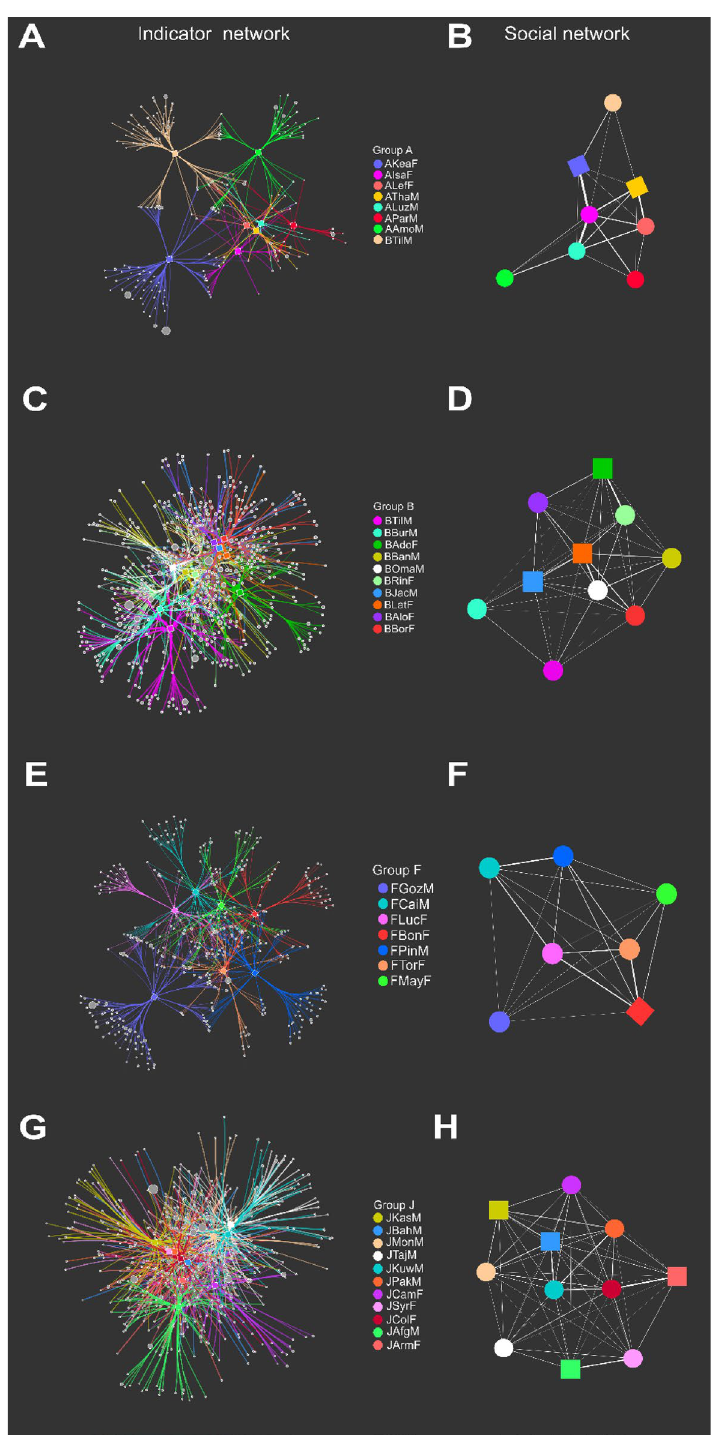
Figure 5. Indicative networks and social networks for the individuals of each group based on ASVs. Networks were colored by individual; nodes are shaped in the social network according to adult (circle) or juvenile/infant (square). Bacterial indicator ASV network and social network of group A ( A and B ), group B ( C and D ), group F ( E and F ) and group J ( G and H